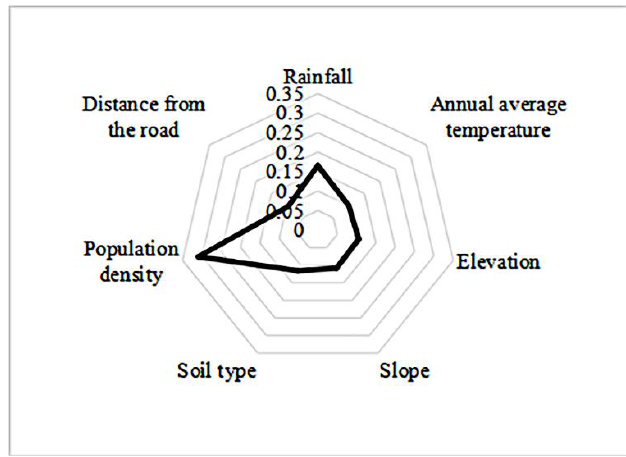
Figure 8. ESV influence factor